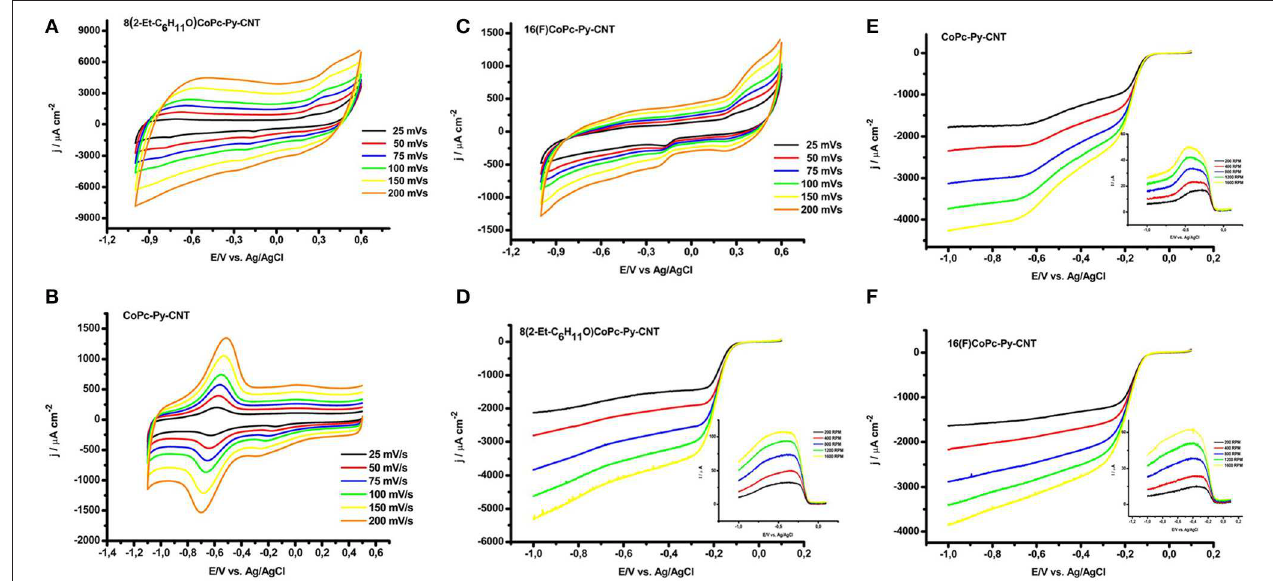
FIGURE 5 | Cyclic voltammetry of (A) 8(2-Et-C 6 H 11 O)CoPc-Py-CNT, (B) CoPc-Py-CNT, (C) 16(F)CoPc-Py-CNT at 25, 50, 75, 100, 150, and 200 mV/s in N 2 saturated NaOH 0.1M. Linear sweep voltammetry of rotating ring disk electrodes at various rotating speeds (i.e., 200, 400, 800, 1,200, 1600 rpm) of (D) 8(2-Et-C 6 H 11 O)CoPc-Py-CNT, (E) CoPc-Py-CNT, (F) 16(F)CoPc-Py-CNT. Inset: oxidative current produce at the Pt ring electrode during the linear sweep voltammetry at the various rotation speeds. Conditions: potential scan rate of linear sweep experiments was 5 mV/s, Pt ring polarized at 0.6V during chronoamperometry, O 2 saturated NaOH 0.1M.